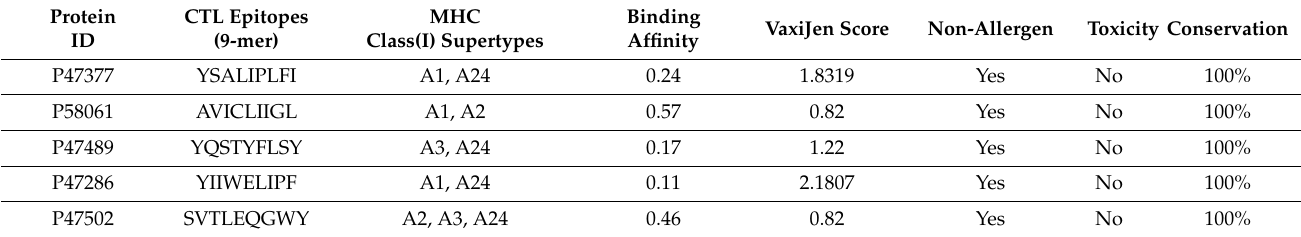
Table 2. Conserved and most immunogenic CTL epitopes.